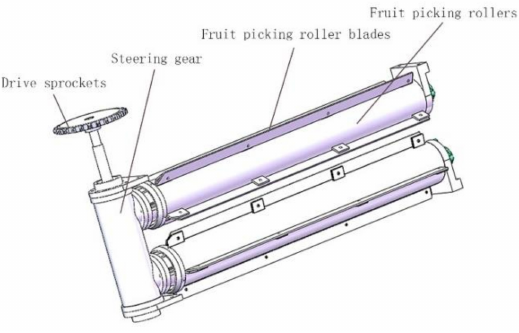
Figure 2. Structure of peanut picking roller